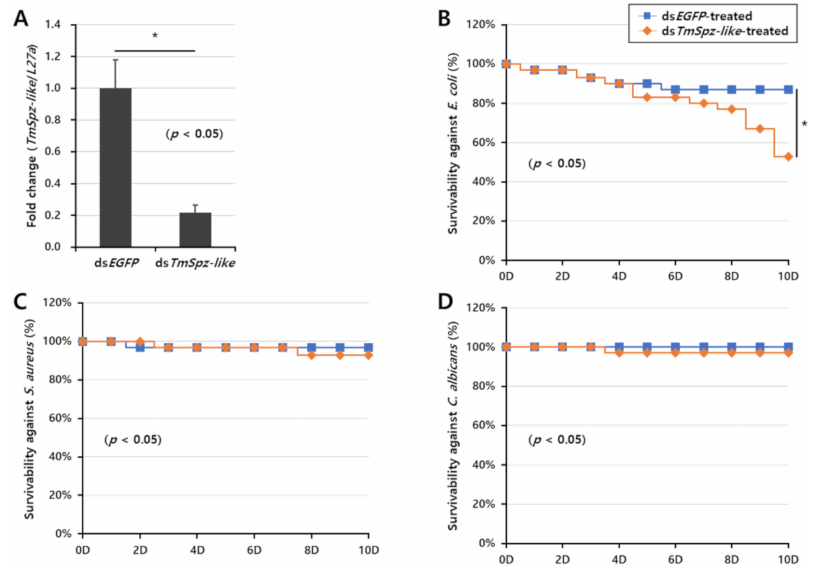
Figure 5. Effect of TmSpz-like knockdown on the viability of Tenebrio molitor larvae. ( A ) TmSpz-like knockdown efficiency measured using quantitative real-time polymerase chain reaction at day 4 post-injection. Viability of TmSpz-like knockdown larvae after challenge with Escherichia coli ( B ), Staphylococcus aureus ( C ), or Candida albicans ( D ) (n = 30). The negative control comprised ds EGFP - injected larvae. Data are presented as average of three biologically independent replicate experiments. Asterisks indicate significant differences between TmSpz-like -knocked down and ds EGFP- treated groups ( p < 0.05). Survival rates were analyzed based on the Kaplan–Meier plots (log-rank chi-square test; * p <